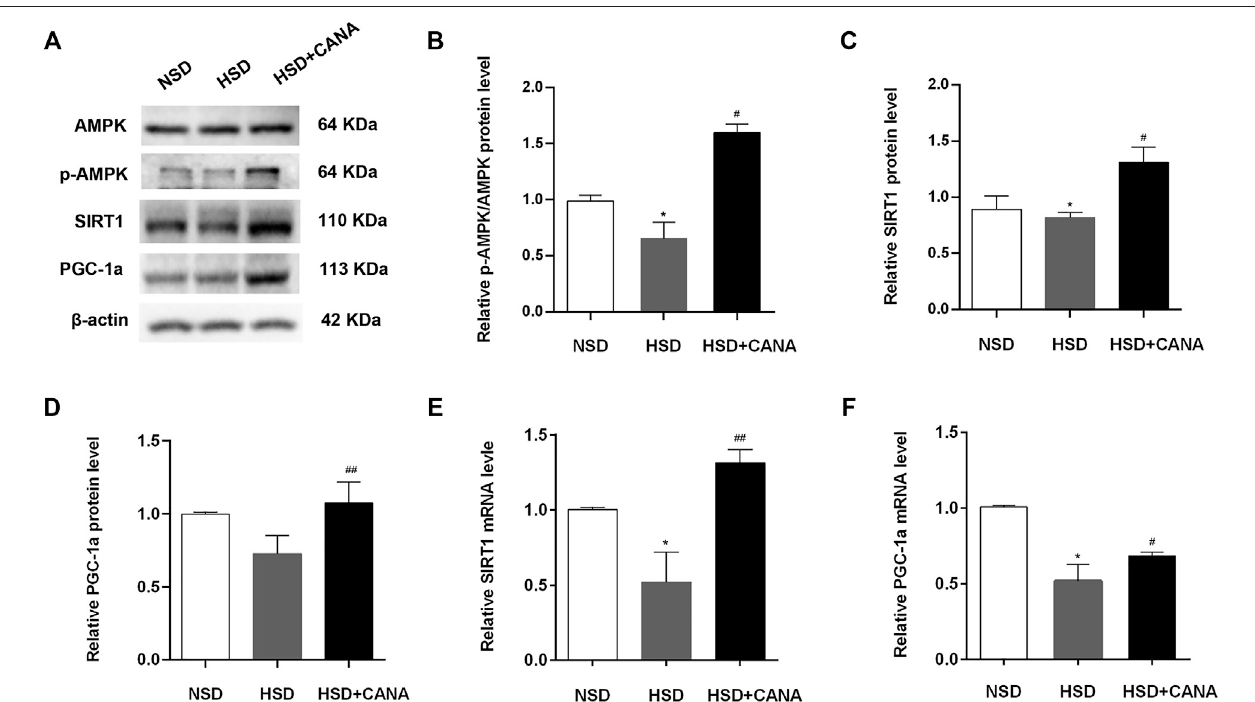
FIGURE 7 | CANA improves the cardiac function by activation of fatty acid oxidation and ketogenesis and reducing oxidative stress through the AMPK/SIRT1/ PGC-1a pathway. (A) The protein expression of AMPK, p-AMPK, SIRT1, and PGC-1a was detected via Western blotting; (B) Quantitative evaluation of the protein expression of AMPK and p-AMPK; (C) Quantitative evaluation of the protein expression of SIRT1; (D) Quantitative evaluation of the protein expression of PGC-1a; (E) ThemRNAexpressionofSIRT1wasdetectedinindicatedgroups; (F) ThemRNAexpressionofPGC-1awasdetectedinindicatedgroups.* p < 0.05vs.NSD. # p < 0.05, ## p < 0.01 vs.